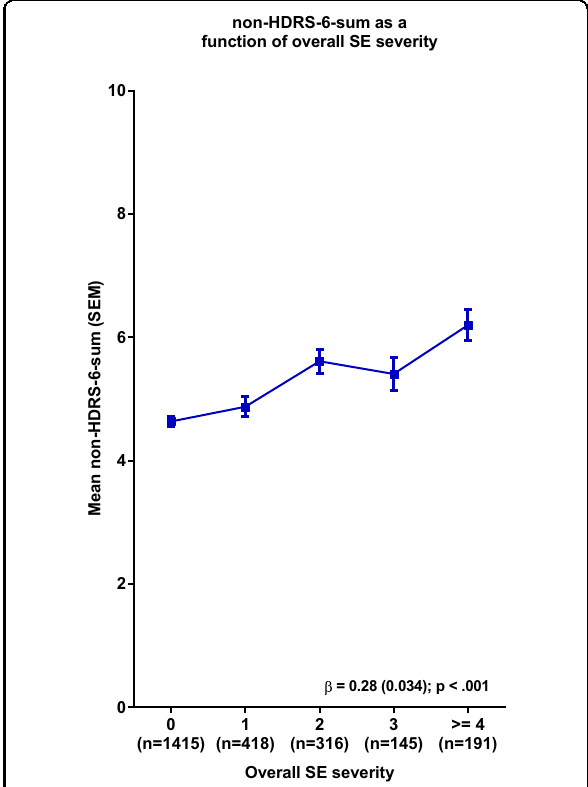
Fig. 3 Endpoint non-HDRS-6 ratings as a function of overall side effect (SE) severity. Side effect severities present in ≤ 50 patients have been collapsed for easier visualisation. β Beta coef fi cient (SEM) for the overall SE severity predictor, SEM standard error of the